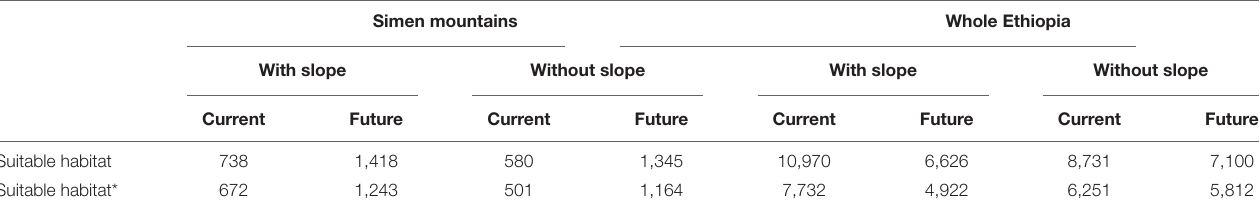
Simen mountains Whole